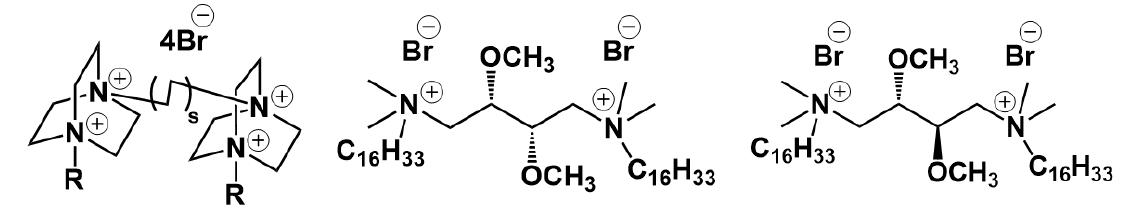
Figure 13. Structural formulas of gemini surfactants.